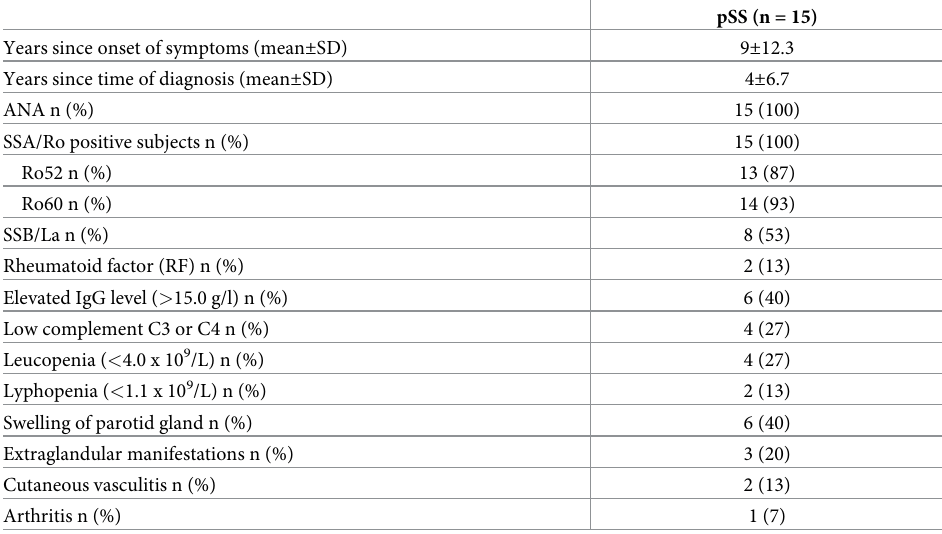
Table 2. Clinical features of the pSS